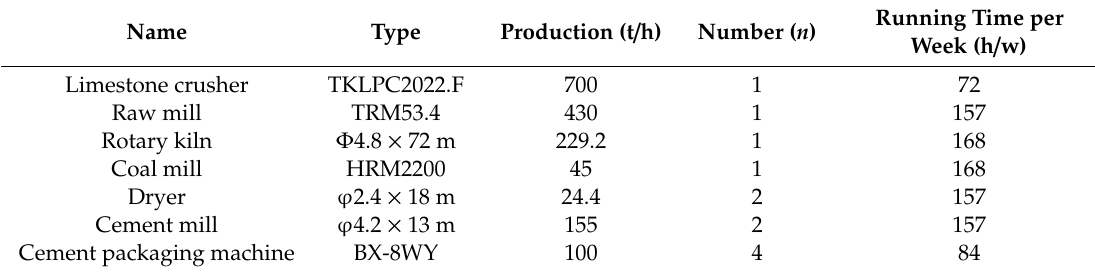
Table 15. Main equipment for the cement production process.